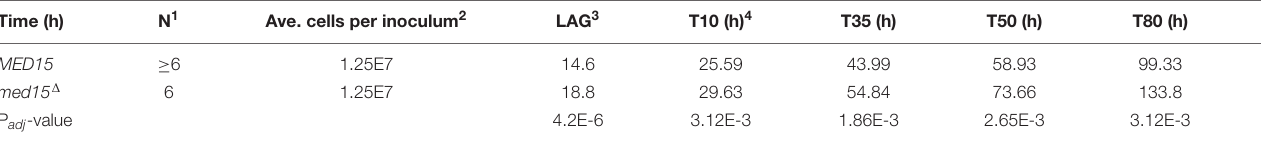
TABLE 2 | Equivalent Times to Weight Loss